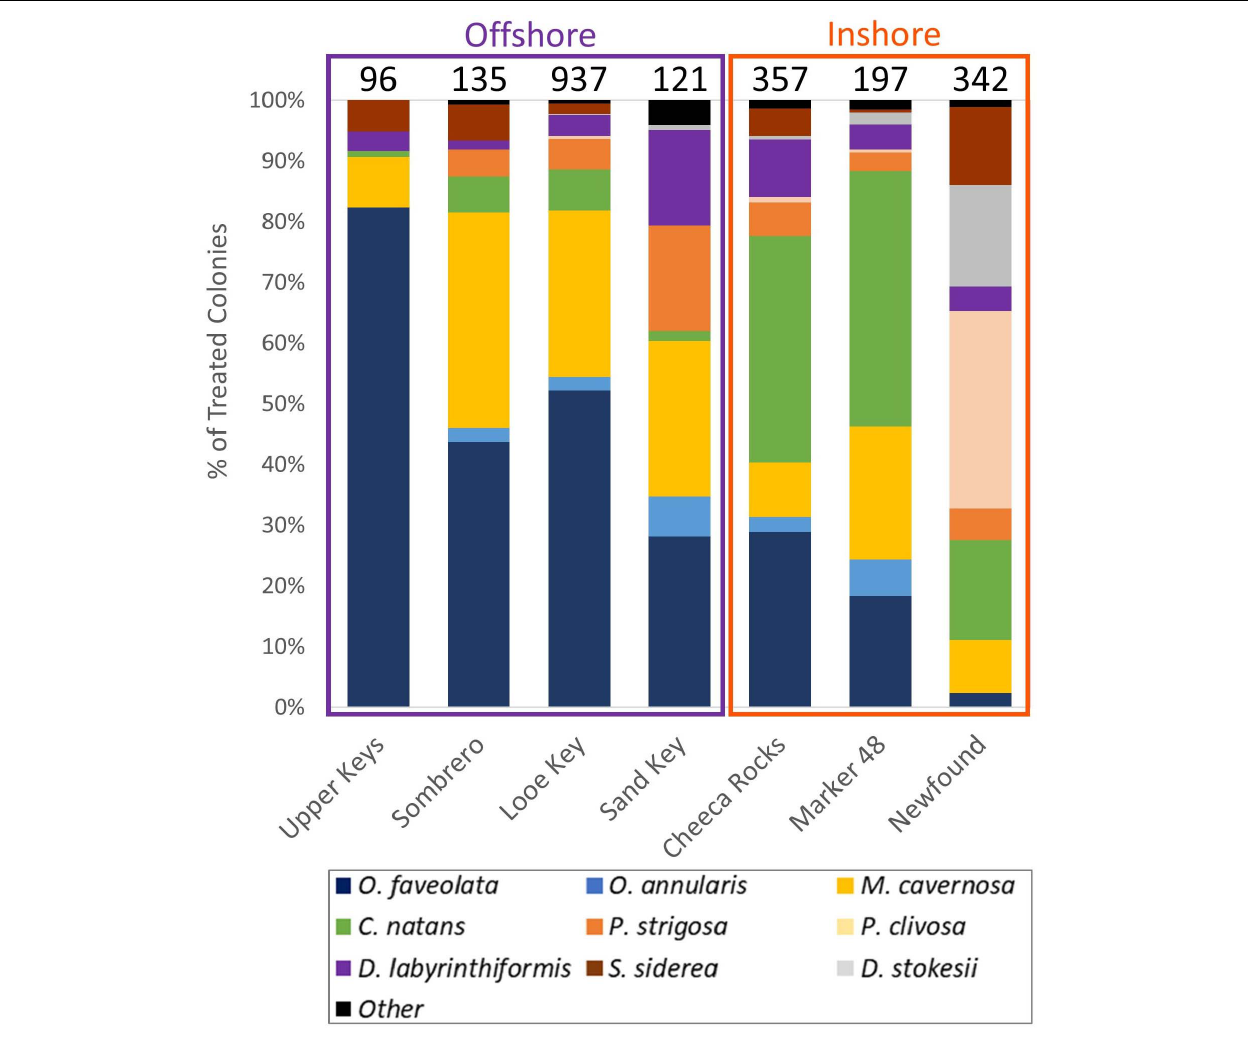
FIGURE 3 | Species composition of corals treated at FKNMS sites. Top numbers indicate the total number of treated corals at each